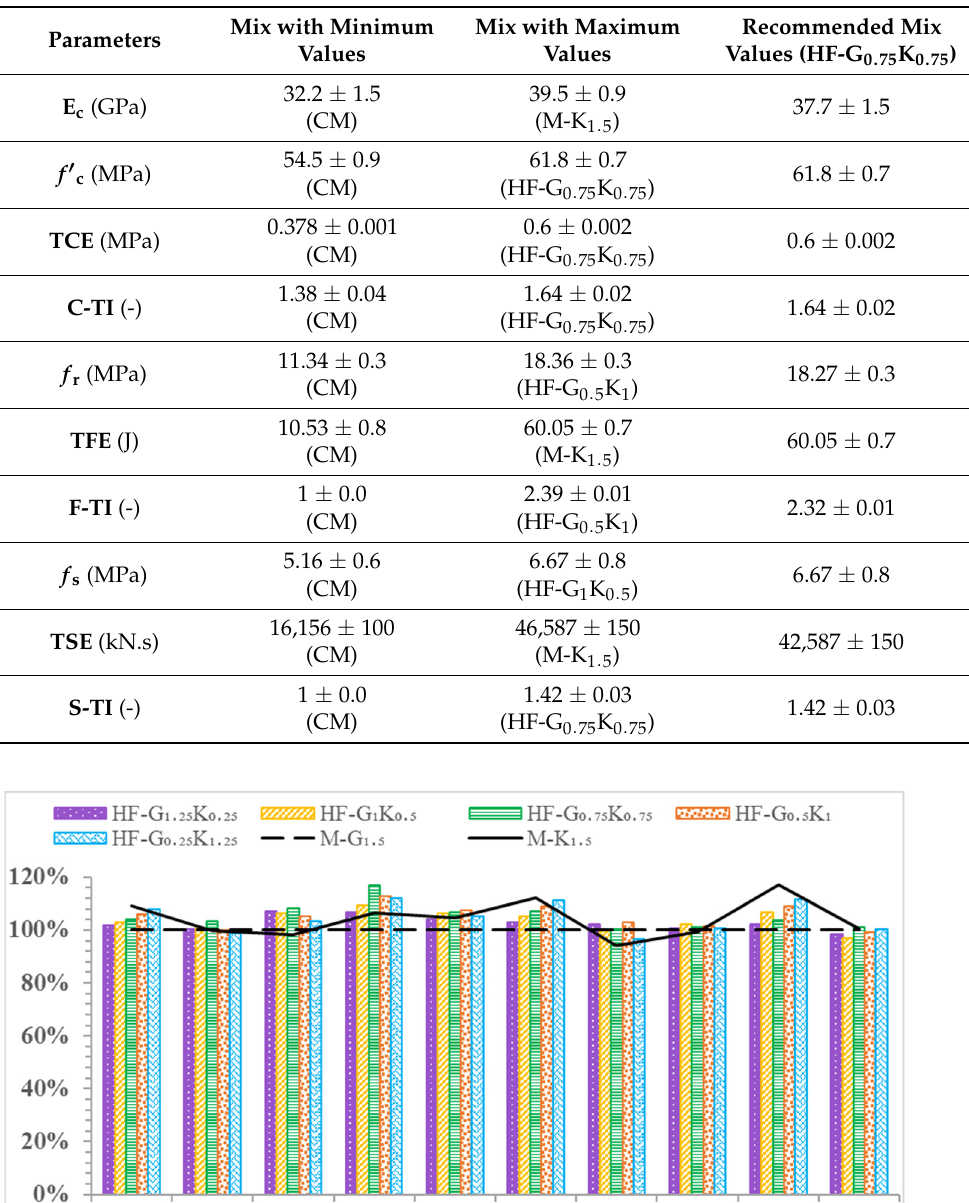
Table 11. Comparison of minimum, maximum, and recommended mixes.